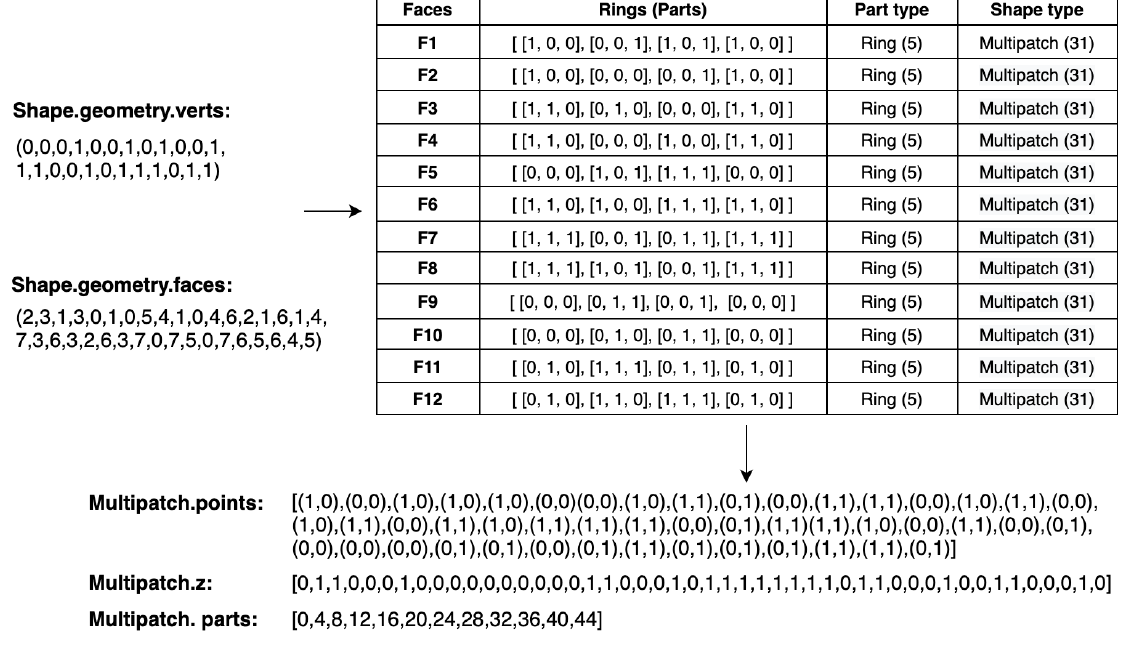
Figure 9. Converting OCCT B-Rep into shapefile B-Rep.